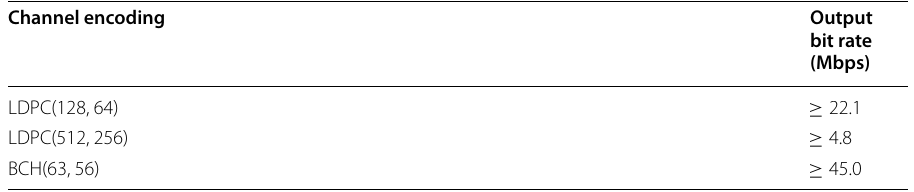
Table 5 Performance achieved by the CPU platform Channel